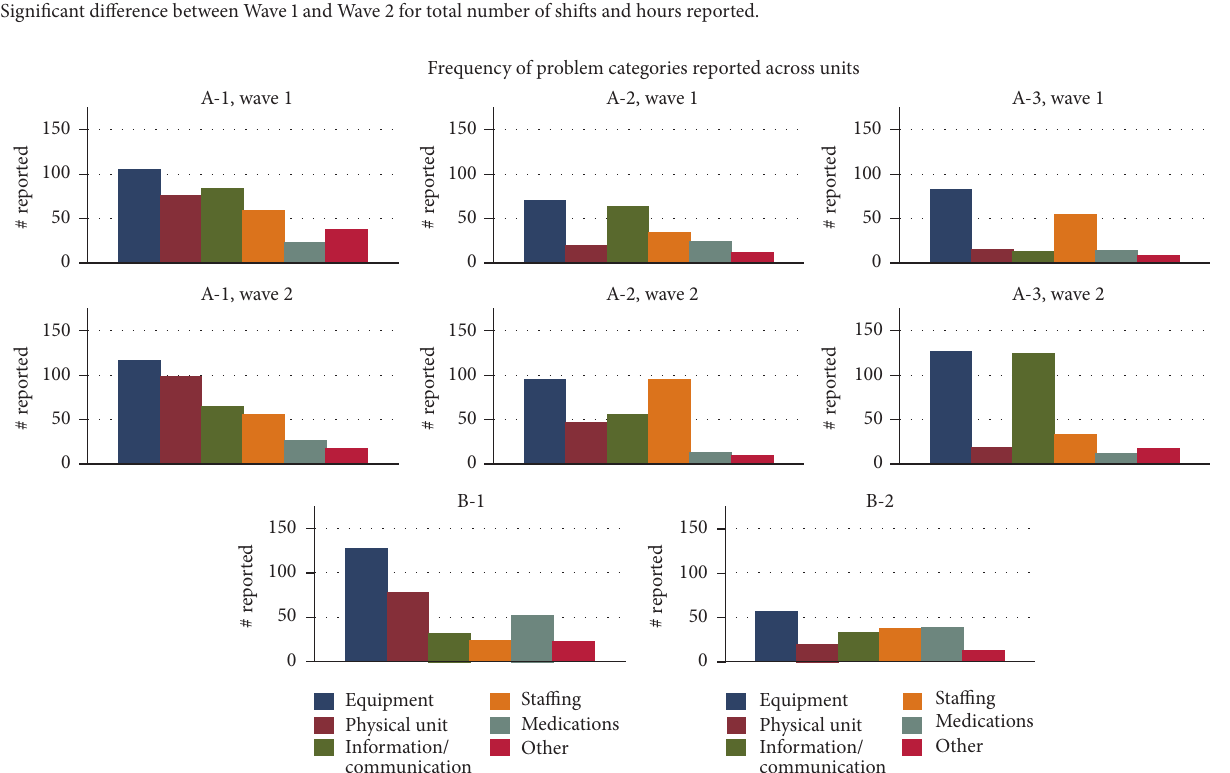
Figure 3: Frequencies for categories of small operational failures, disaggregated by unit and